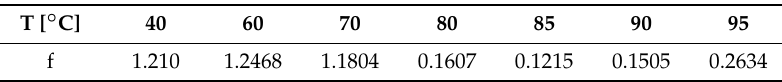
Table 6. Correction Factor for the Air–5% NaCl System in Equation